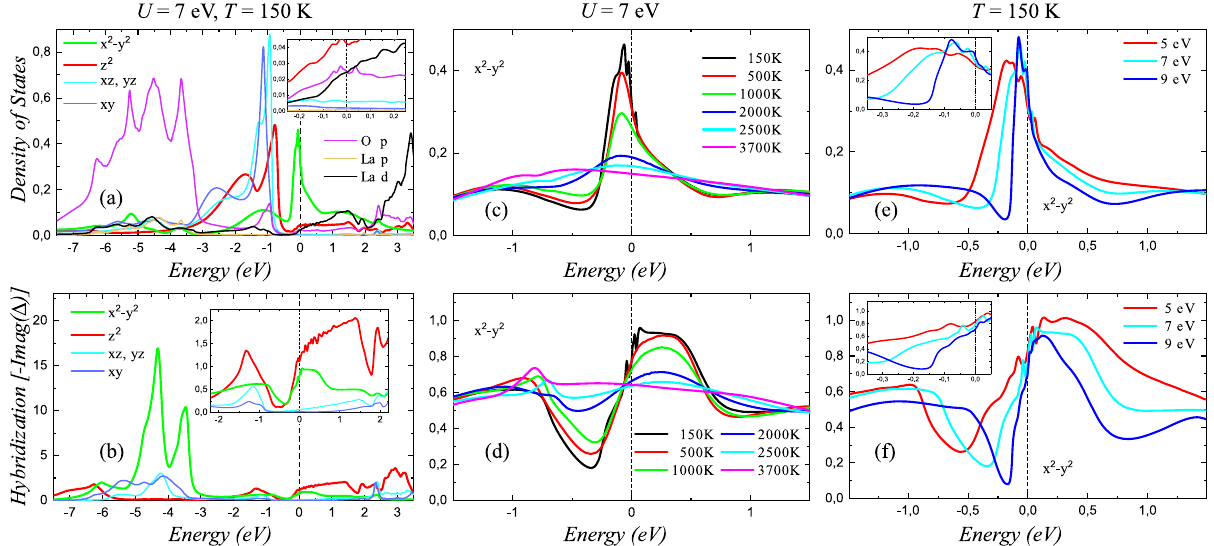
Fig. 3 Density of states (DOS) and hybridization for LaNiO 2 . a shows the projected DOS for all the Ni- d orbitals, as well as the O- p , La- p and La- d orbitals. b shows the hybridization corresponding to the Ni- d orbitals. c , d show the temperature ( T ) dependence of the Ni- d x 2 (cid:3) y 2 projected DOS and the corresponding hybridization, while e , f show the correlation ( U ) dependence of the same Ni- d projected DOS and the corresponding hybridization. The insets focus on the energy region around the Fermi level, which is marked by the zero on the energy axis.